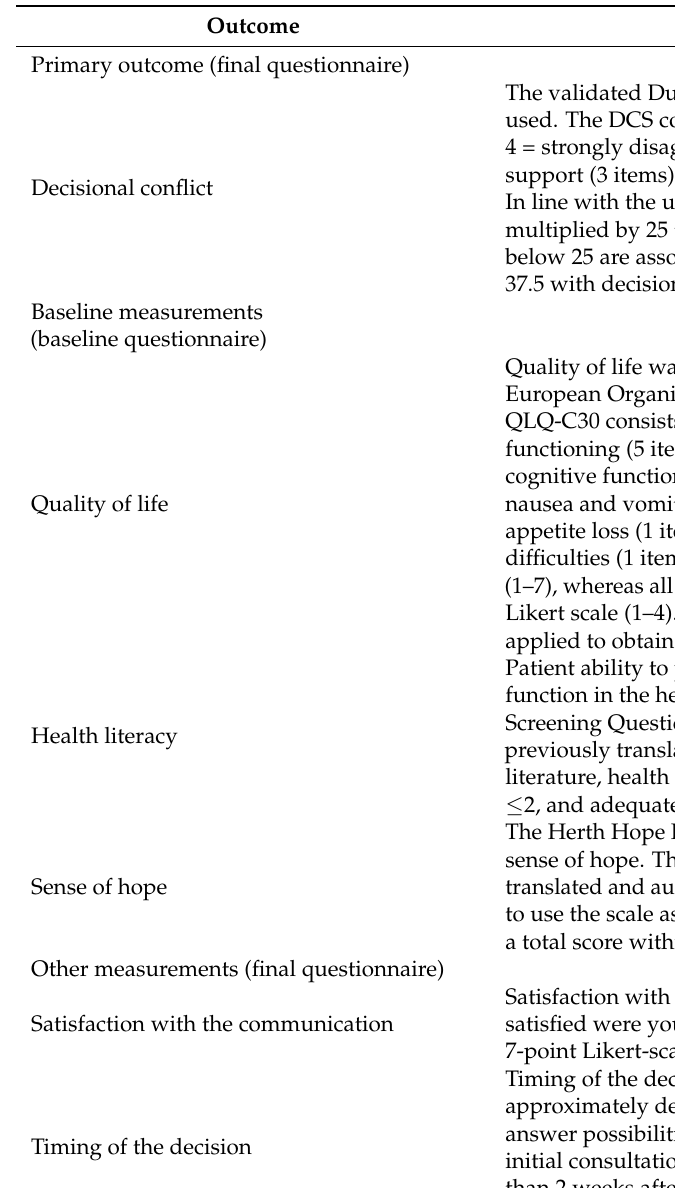
Table 1. Overview of